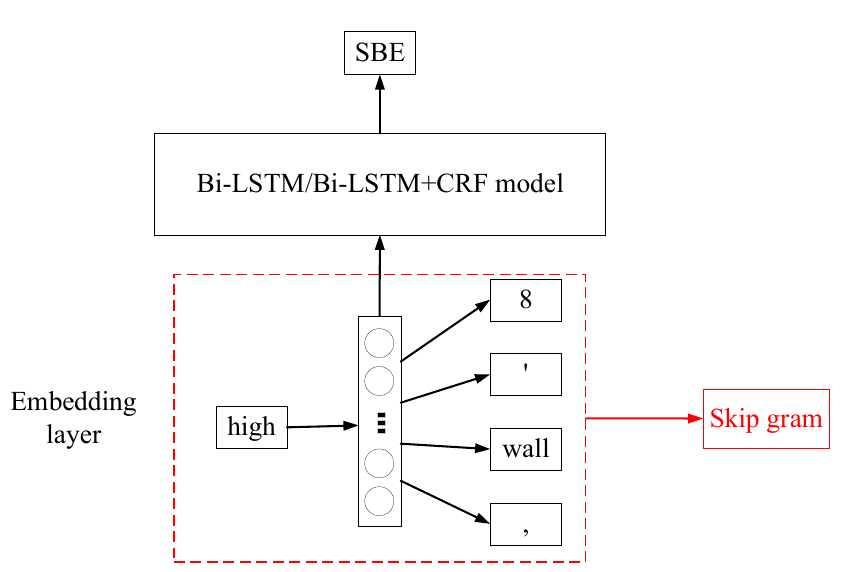
Figure 7. Word embedding for the Bi-LSTM/Bi-LSTM+CRF model.